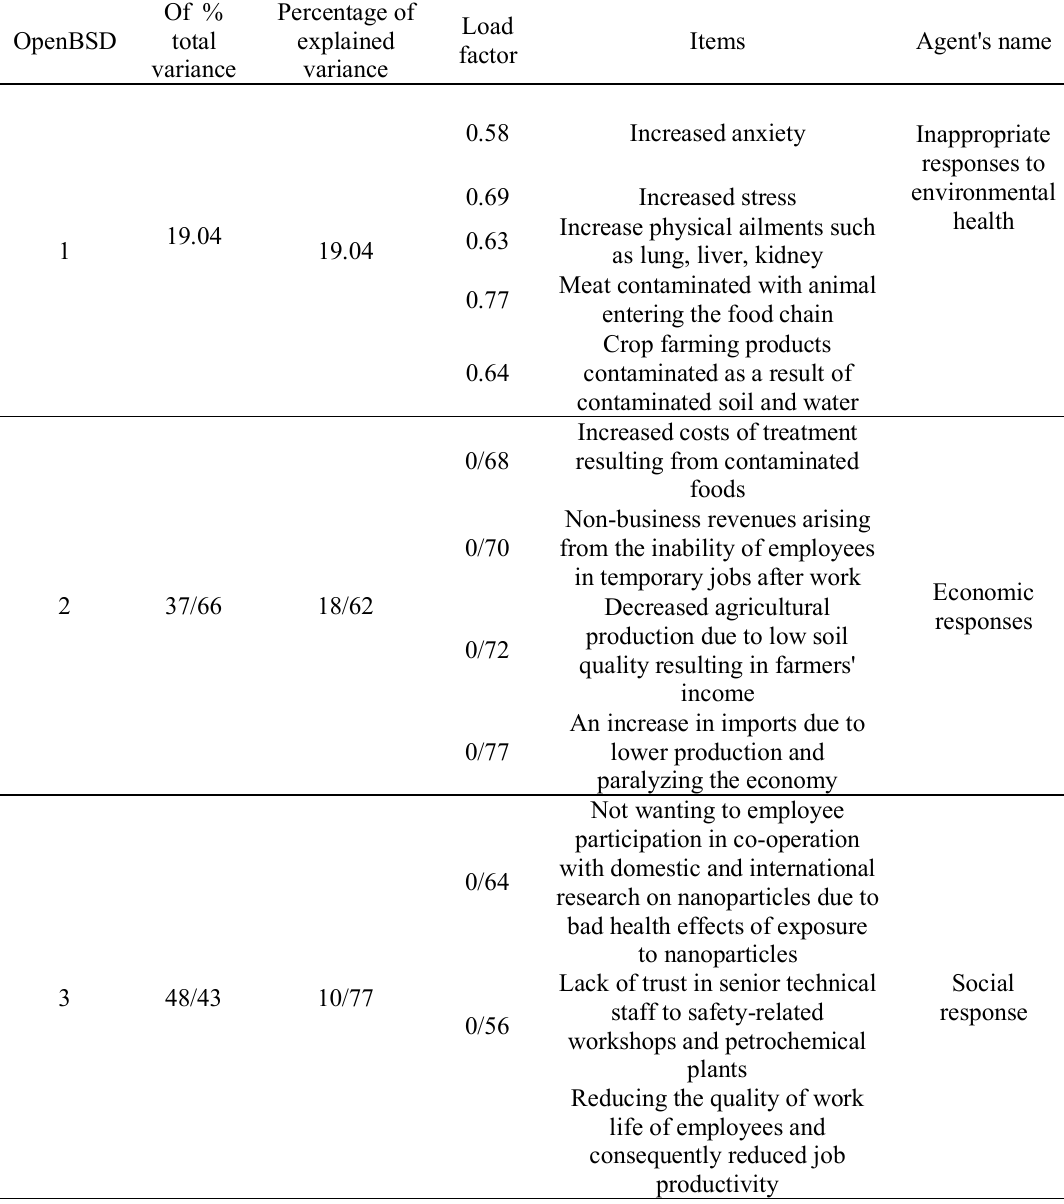
Table 8. Results of factor analysis of responses to the crisis caused by the release of